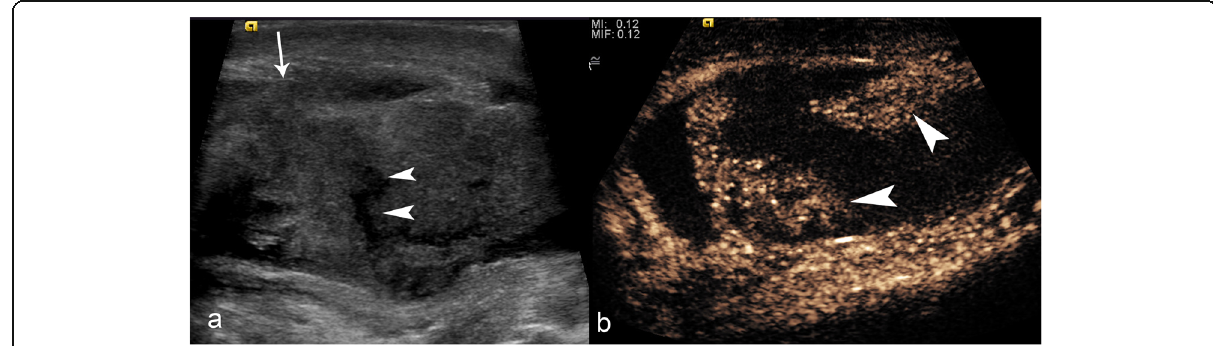
Fig. 5 Conventional US and CEUS findings of testicular rupture. On B-mode ( a ), a hypoechoic linear disruption of the testicular parenchyma is demonstrated (arrowheads). Note the discontinuation of tunica albuginea with protrusion of echogenic material, indicating rupture (arrow). CEUS ( b ) determined the amount of viable parenchyma (arrowheads) which aided in pre-operative decision-making and allowed for the salvaging of viable testicular tissue avoiding the need for